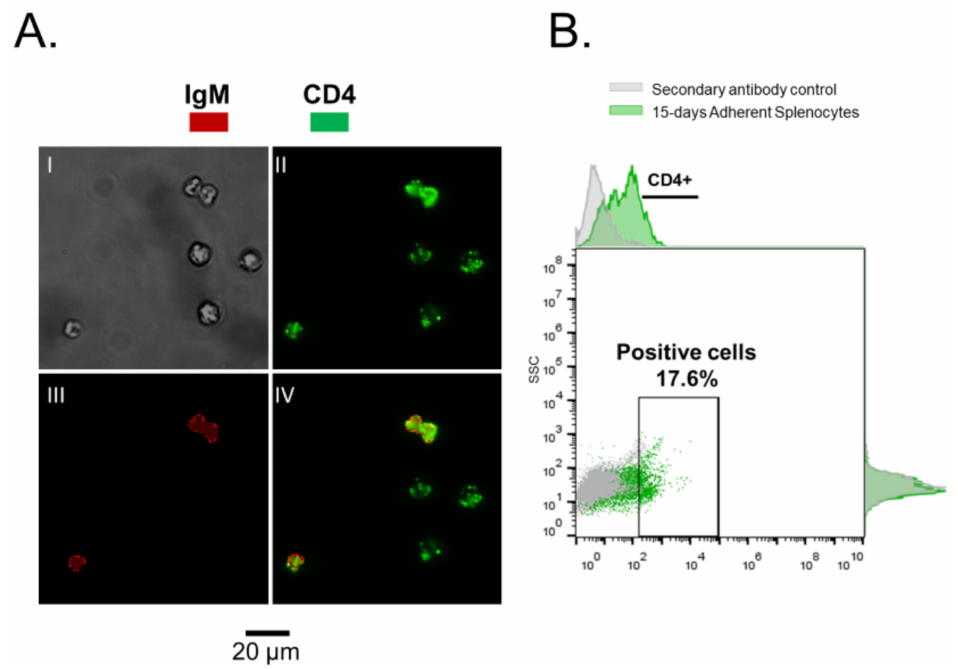
Figure 1. Non-adherent splenocytes, cultured for 15 days. ( A ). Immunofluorescence (IFAT) on mononuclear splenocytes, I—phase contrast, II—in green CD4, III—in red IgM, IV—Merged. ( B ). CD4 + cells. In gray—secondary antibody control. In green—non-Adherent